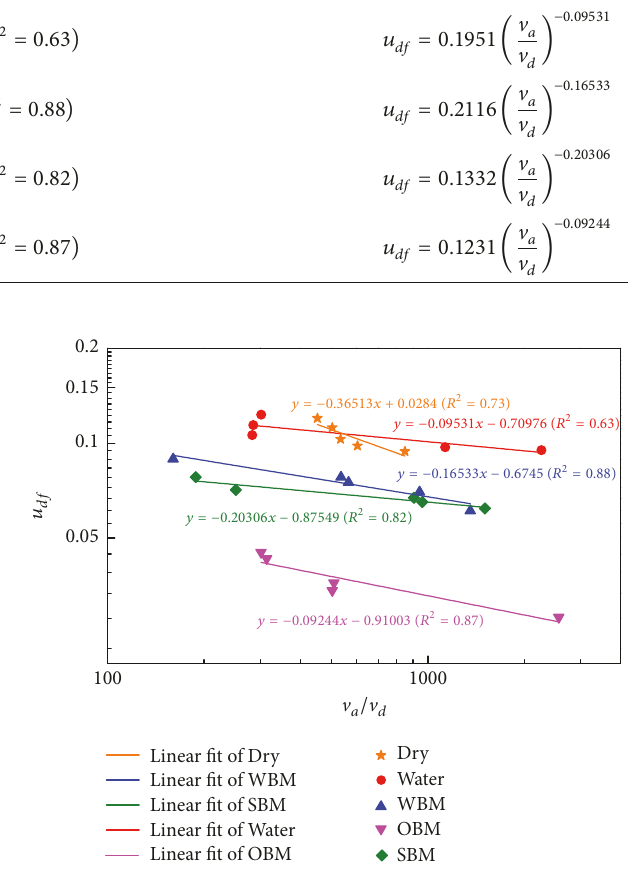
Figure 11: The plot of 𝑢 𝑑𝑓 versus V 𝑎 / V 𝑑 in logarithmic coordinates under different lubrication